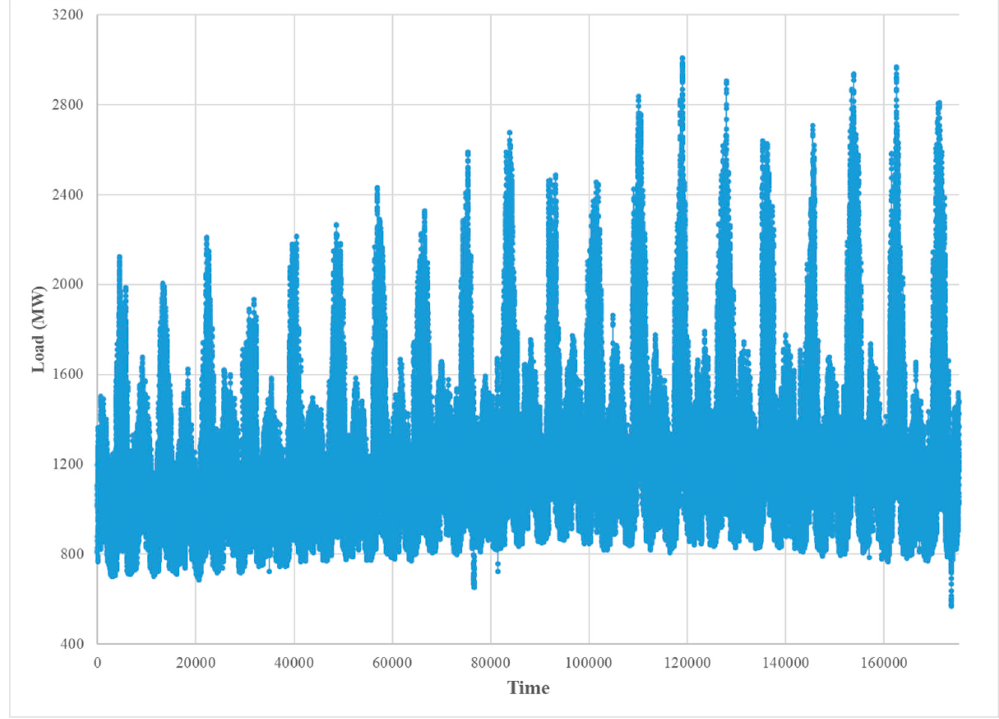
Figure 5. The hourly observed load over 20 years.